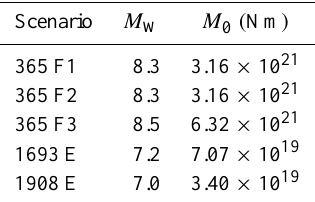
Table 1. Magnitude ( M w) and seismic moment ( M 0 ) for the earth- quake scenarios considered. M 0 has been derived from M w by means of the Hanks and Kanamori (1979) law. Seismic parame- ters have been determined using empirical regression curves (Wells and Coppersmith, 1994; Blaser et al., 2010; Strasser et al., 2010), assuming the rigidity parameter µ equal to 30 GPa.